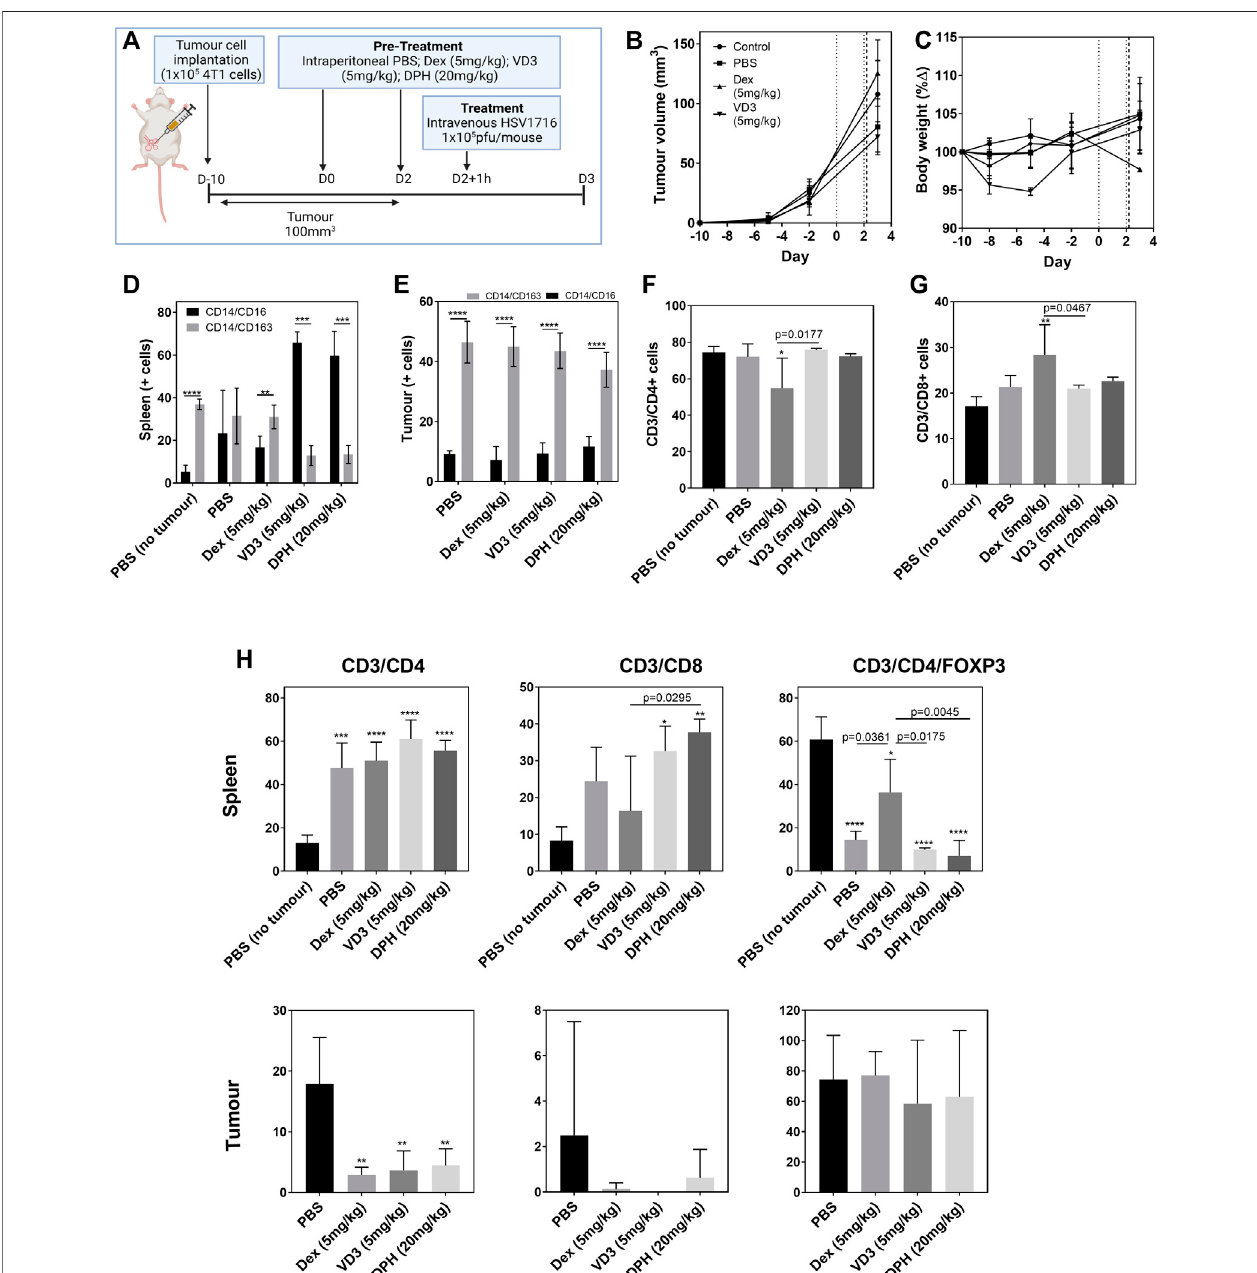
FIGURE 3 | Prophylactic immunomodulation to enhance OV ef fi cacy. Tumor-bearing Balb/c mice ( n = 4/group) were pre-treated intraperitoneally with different immunomodulators (vertical dotted lines) prior to intravenous OV administration (vertical dashed line) [ (A) , created using BioRender] in an effort to alter the immune microenvironment for enhanced ef fi cacy and tolerability. Tumor volume (B) and body weight (C) were measured prior to killing 24 h post OV treatment. Dissociated cell populations from spleen (D) and tumor (E) samples were analyzed by fl ow cytometry for pro-in fl ammatory (CD14 + /CD16 + ) or immunosuppressive markers (CD14 + /CD163 + ). Lymphocytes harvested from blood samples were positively selected for CD4 + (F) and CD8 + (G) T-cell markers. T-cell analysis from cell populations within spleen and tumor samples was also quanti fi ed (H) . Data are shown as mean ± SD. Statistical signi fi cance was determined by one-way ANOVA with a Tukey post ho c test where p = p < 0.05, pp = p < 0.001, and pppp = p < 0.0001 versus PBS no